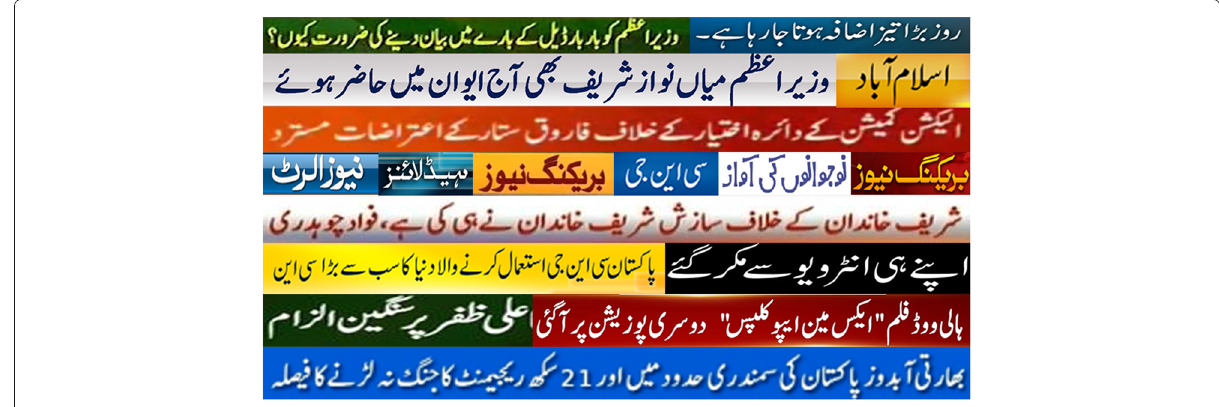
Fig. 11 Sample images of text lines for model training